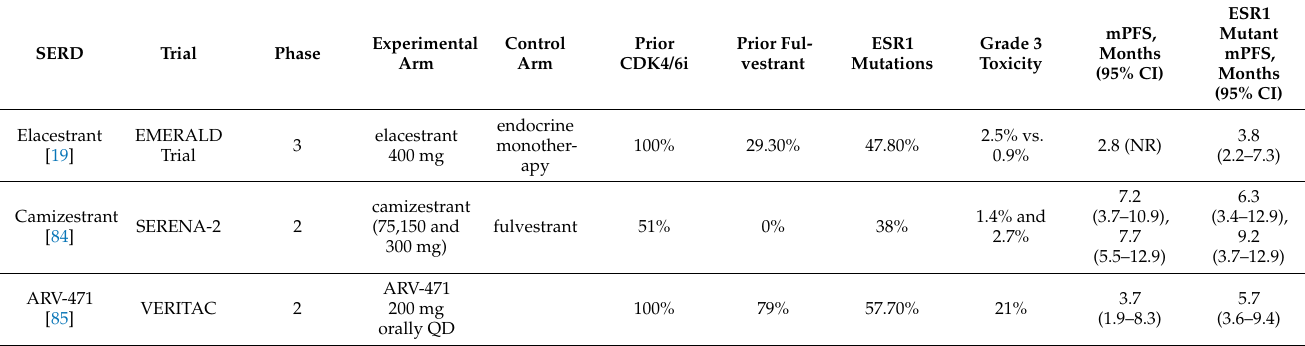
Table 2. Positive studies of oral SERDs (including